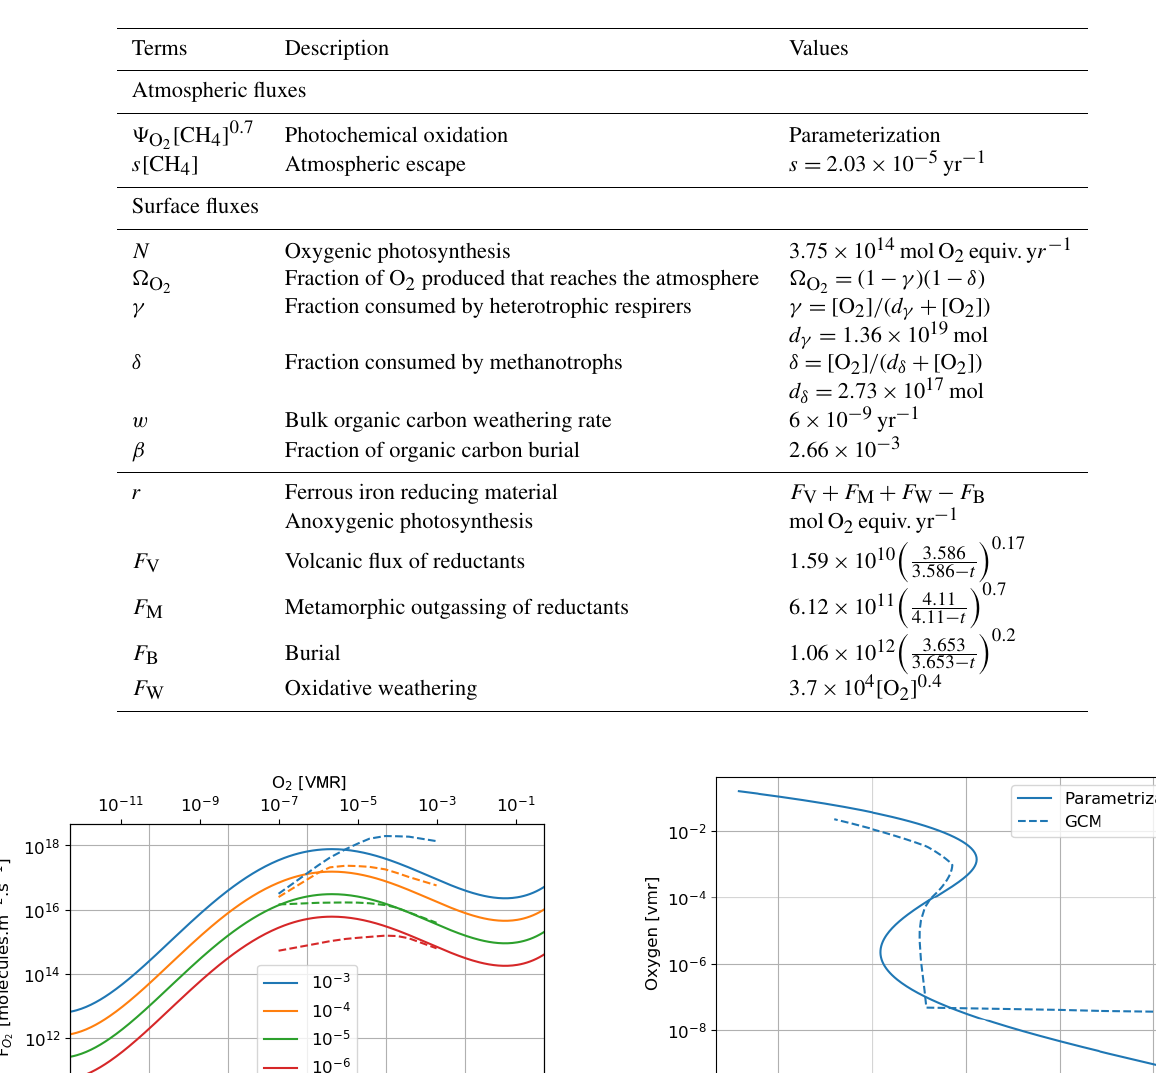
Table 2. Equation dependencies and values from Goldblatt et al. (2006). Reductant model from Claire et al. (2006) with time t (Gyr) and amount of oxygen [ O 2 ] (mol).